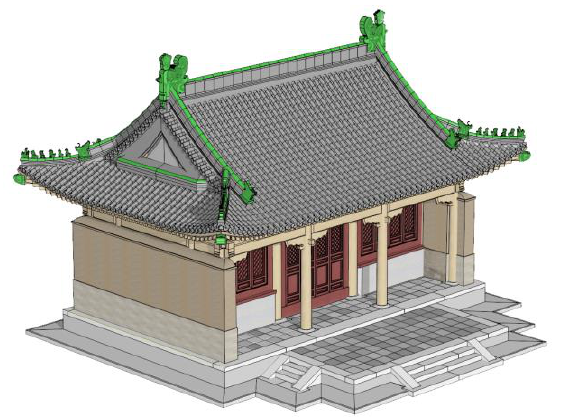
Figure 16. BIM model for the Main Hall of Lu Ban Shrine, Jizhou, Tianjin